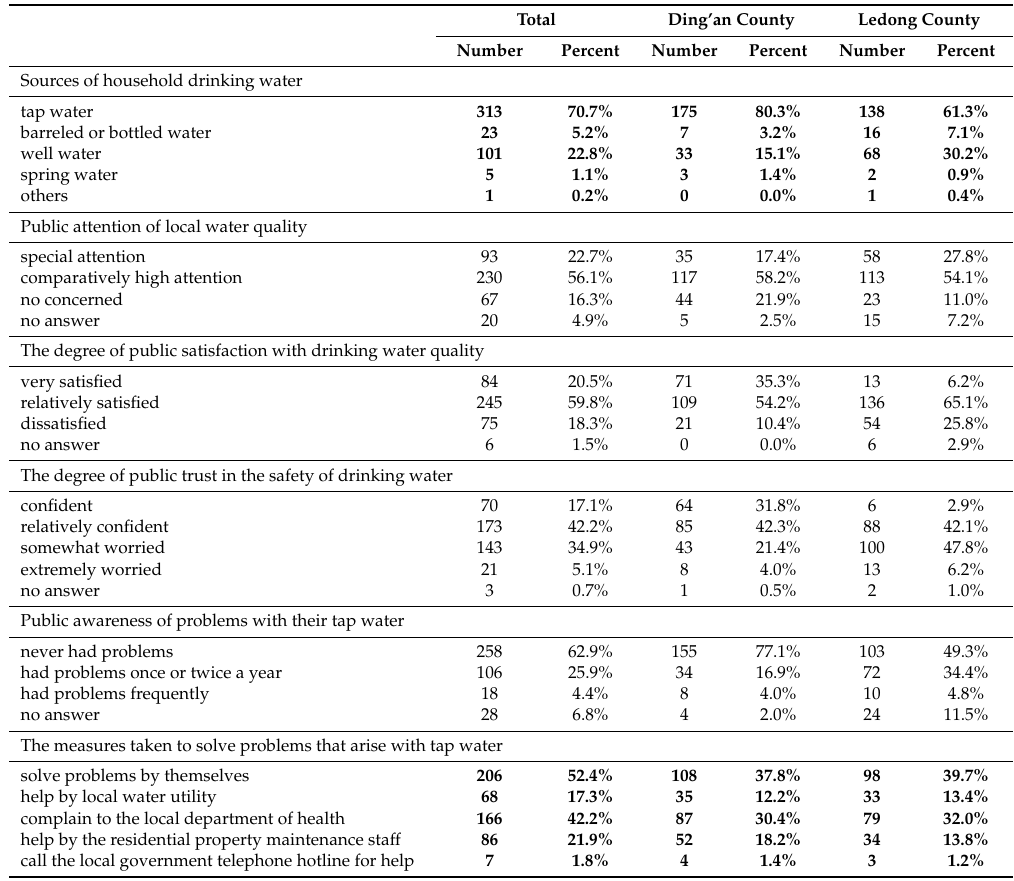
Table 3. Statistical analysis of public awareness of drinking water safety. Total Ding’an County Ledong